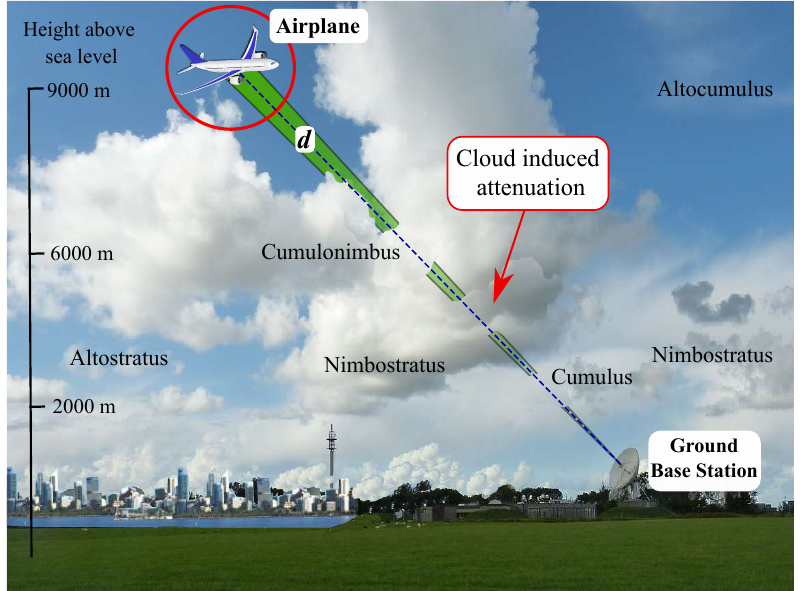
Figure 3. A direct communications link between ground-mounted designated BS and an